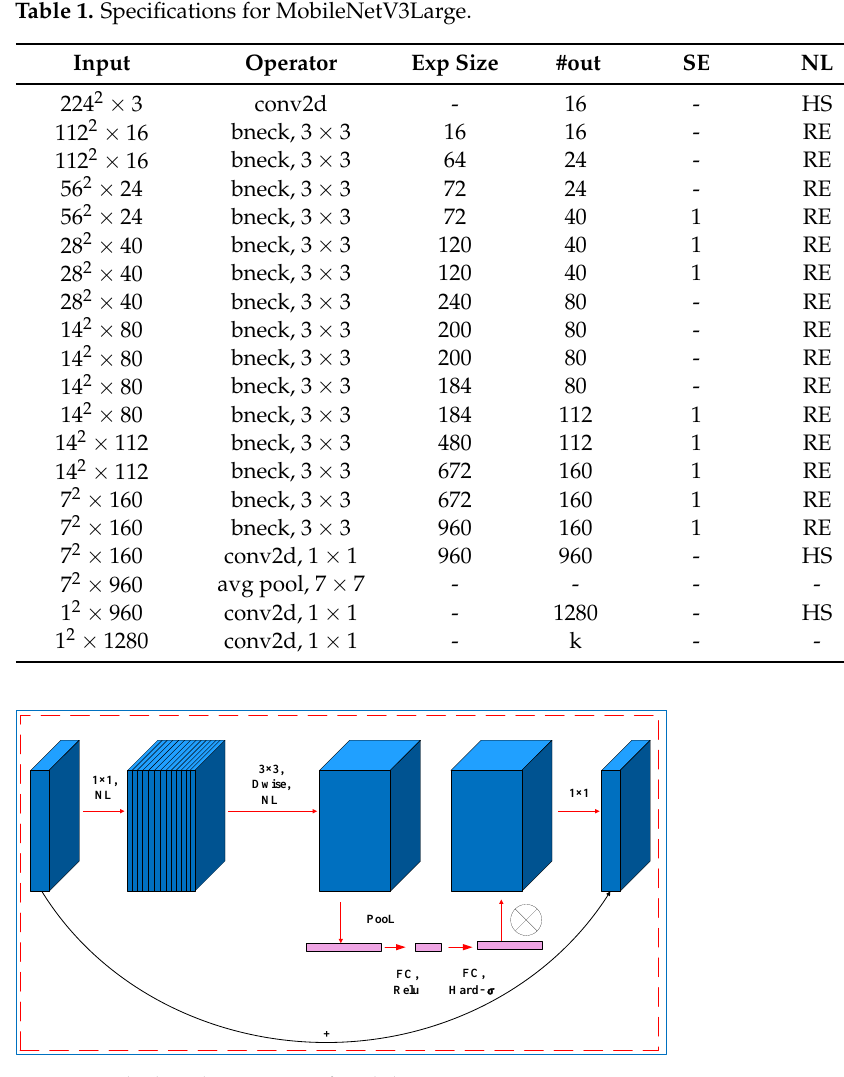
Figure 6. The bneck structure of